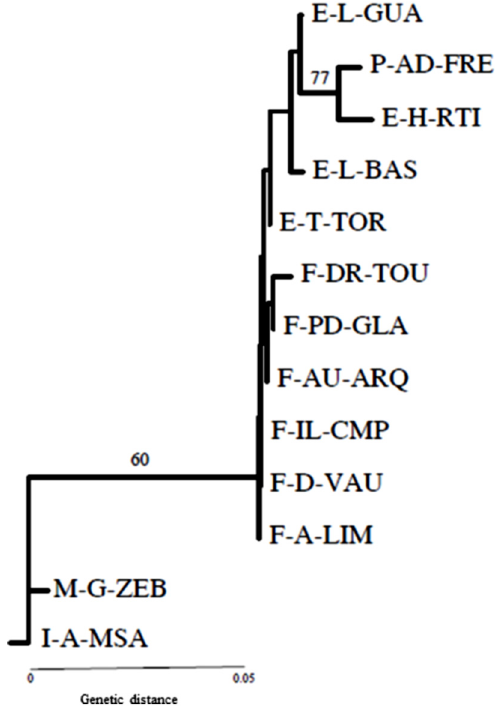
Figure 1. Neighbor-joining phenetic analysis of Nei ’ s genetic distances among 13populations of P. perniciosus